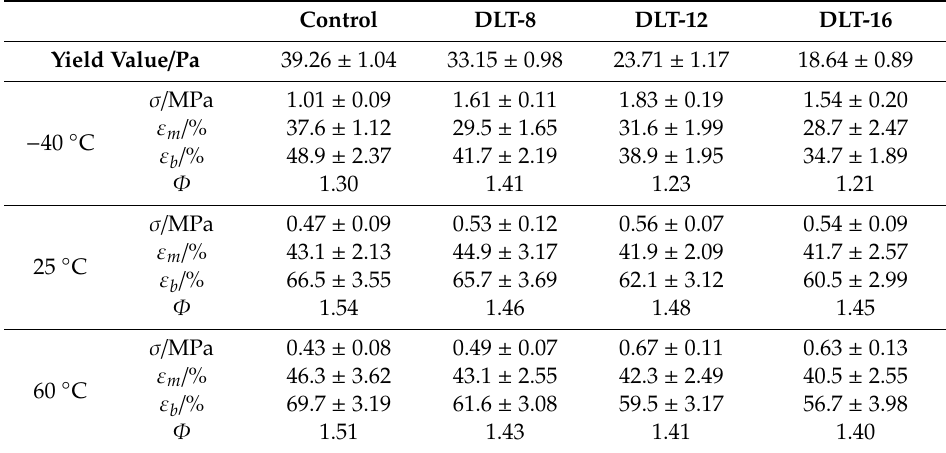
Table 2. E ff ects of the chelated titanate bonding agents on the mechanical properties of HTPB composite